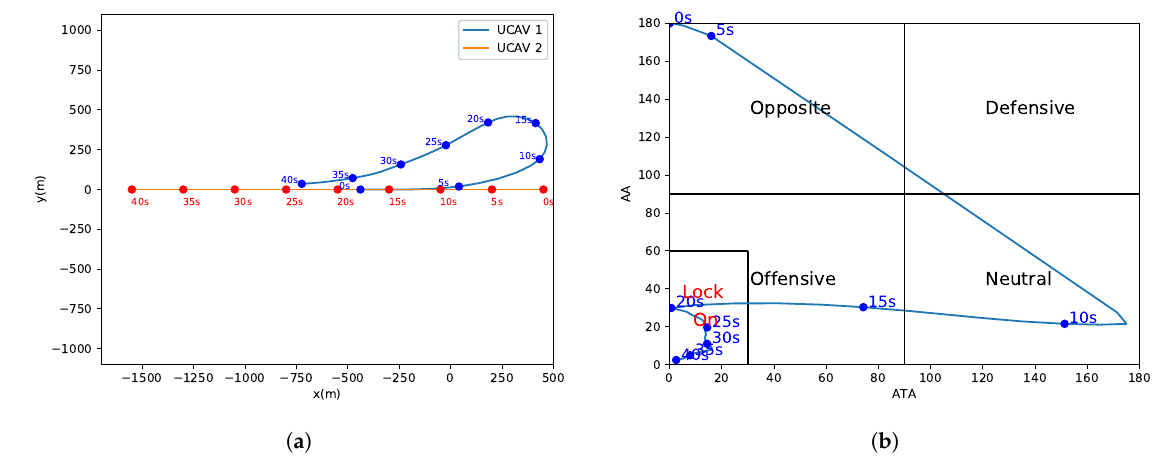
Figure 8. ( a ) Curve of the fly trajectory against “uniform linear motion” strategy. ( b ) Curve of the change in air combat situation against “uniform linear motion”